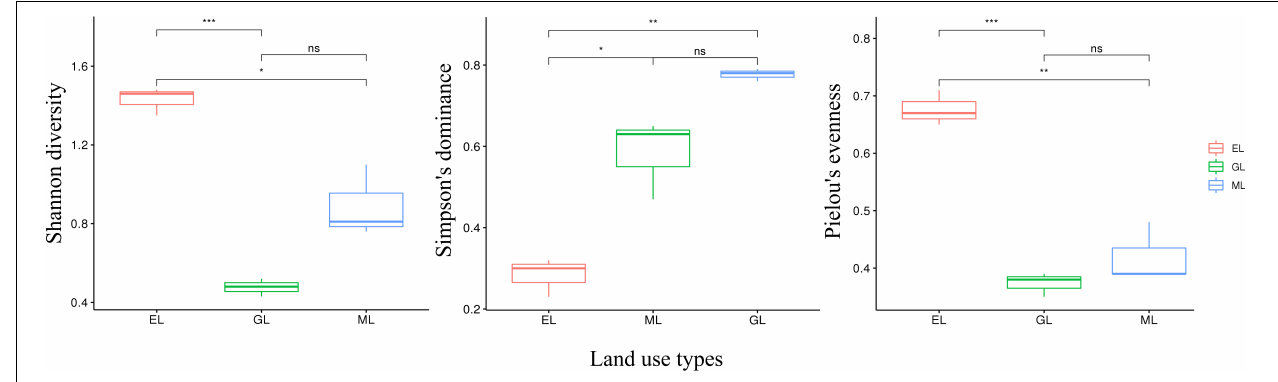
FIGURE 2 | Plant alpha diversity in different land use types. EL, exclosure; ML, mowed land; and GL, grazed land. In the FL, the plant community composition was monospecific, thus it was not included in the analysis. * P < 0.05, ** P < 0.01 and *** P < 0.001.